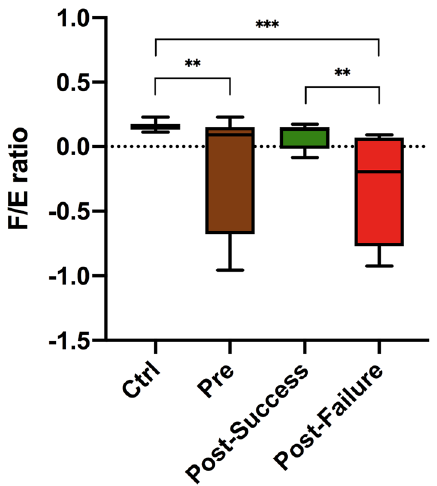
Figure 7. F/E ratio results. Statistical analysis using the Kruskal–Wallis test with Benjamini–Hochberg correction for multiple comparisons (false discovery rate). Asterisks refer to the corrected p-value, where *